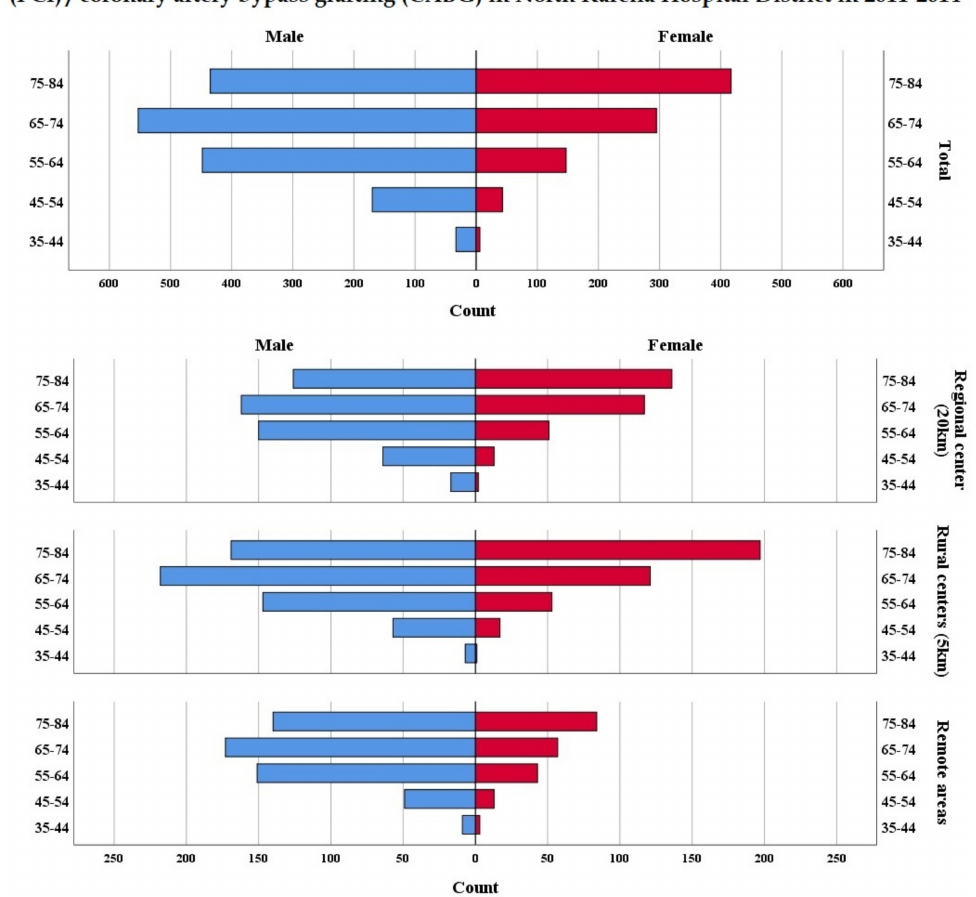
Figure 2. Age structure of patients with acute coronary syndrome (ACS) and/or percutaneous coronary intervention (PCI)/coronary artery bypass grafting (CABG) in North Karelia Hospital District catchment area in 2011–2014 classified by settlement